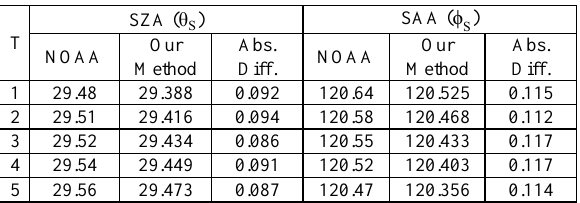
Table 3. Comparison of solar angles between NOAA Solar Calculator and our method. Abs. Diff. indicates the absolute differences between two methods and T is the order of points mentioned in Figure